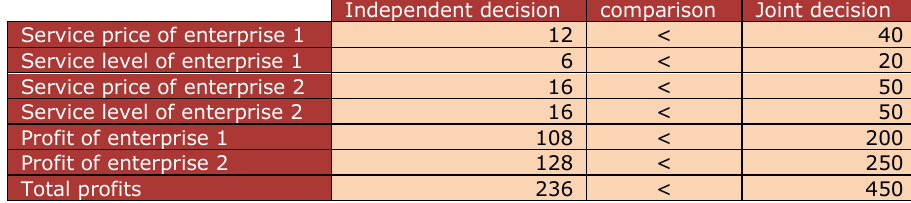
Table 1. Related results under independent decision and joint decision